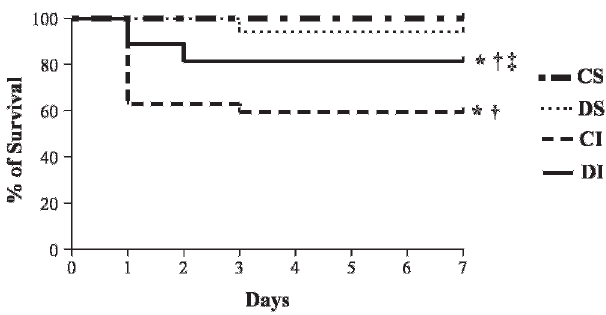
Figure 2 - Mortality rates, as estimated by Kaplan-Meier survival curves for the control sham (CS), diabetes sham (DS), myocardial infarction (CI), and diabetes + myocardial infarction (DI) rats. * p , 0.05 vs . CS; { p , 0.05 vs . DS; { p , 0.05 vs .